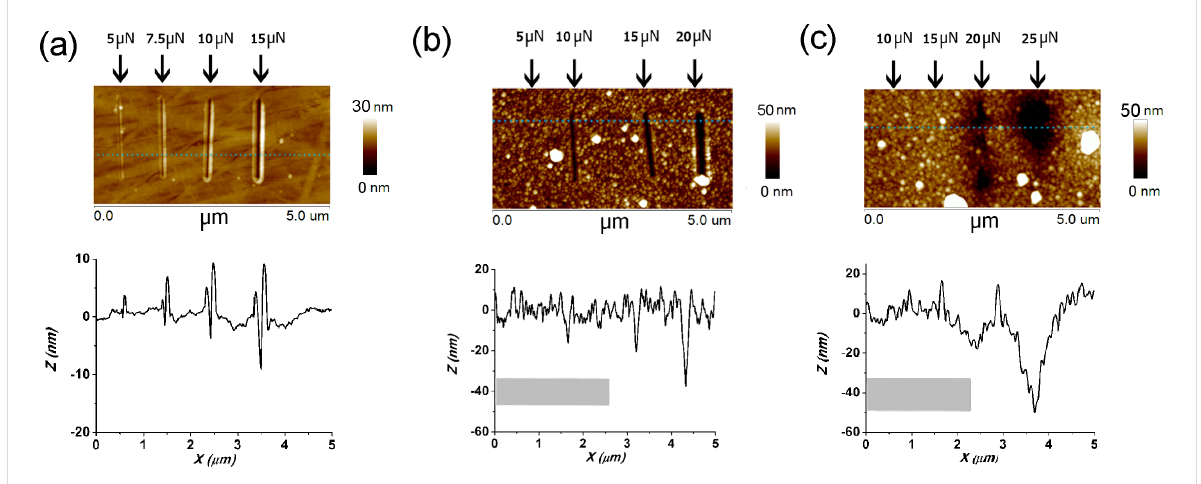
Figure 7: AFM images showing results of scratch tests on coated and uncoated PC at the loads indicated. (a) no coating (b) 40 nm titania coating (c) 40 nm titania on activated PDMS. Cross profiles taken at the dashed lines show the breadth and depth of scratch, with unperturbed surface set to 0 height and scratch depths appearing as negative values. The grey band centered at − 40 nm in (b) and (c) shows the approximate PC substrate pos- ition and average titania roughness.